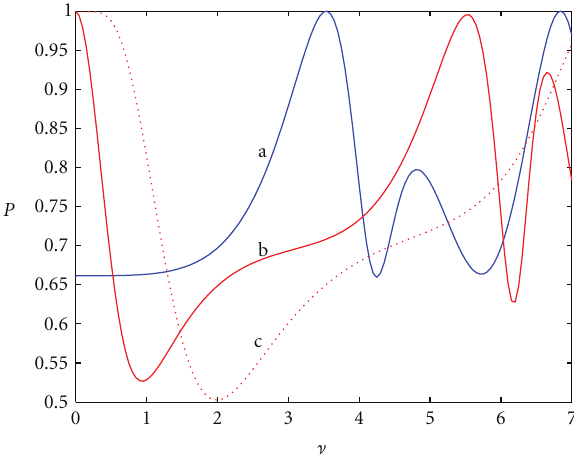
Figure 3: Intensity profile of uniformly polarized vortex beams with NA = 0 . 9, μ o = 0 . 5, β = π/ 2, for m (a) 0, (b) 1, and (c) 2.